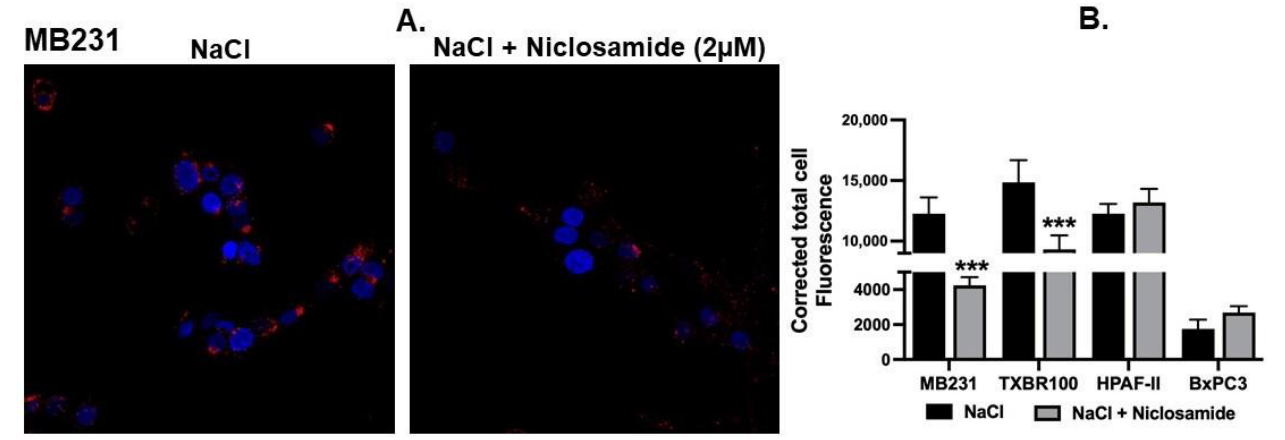
Figure 3 . Effect of niclosamide on basal macropinocytosis. ( A ) Cellular uptake of TMR-dextran was used to monitor macropinocytosis activity in MB231 cells. The perifusion buffer contained NaCl. The assay was done in the absence or presence of niclosamide (2 μ M). ( B ) The experiment was repeated in three other cell lines (TXBR-100, HPAF-II and BxPC3), and fluorescence signals were quantified as CTCF (corrected total cell fluorescence) for all four cell lines. Data (mean ± S.E.M.) are shown. ***, p < 0.001.